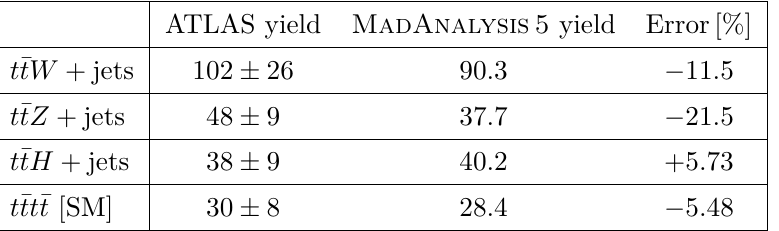
Table 4 . Comparison of signal and leading background event yields reported in table 3 of ATLAS- CONF-2020-013 [3] and obtained using our reimplementation of this analysis in MadAnalysis 5 . t ¯ tt ¯ t yields are normalized to SM cross section of σ ( pp → t ¯ tt ¯ t ) ≈ 12 fb. events, and all other events for this work, in version 3.1.0 of MadGraph5 _ aMC@NLO ( MG5 _ aMC ) [86, 87], with showering and hadronization performed within MG5 _ aMC